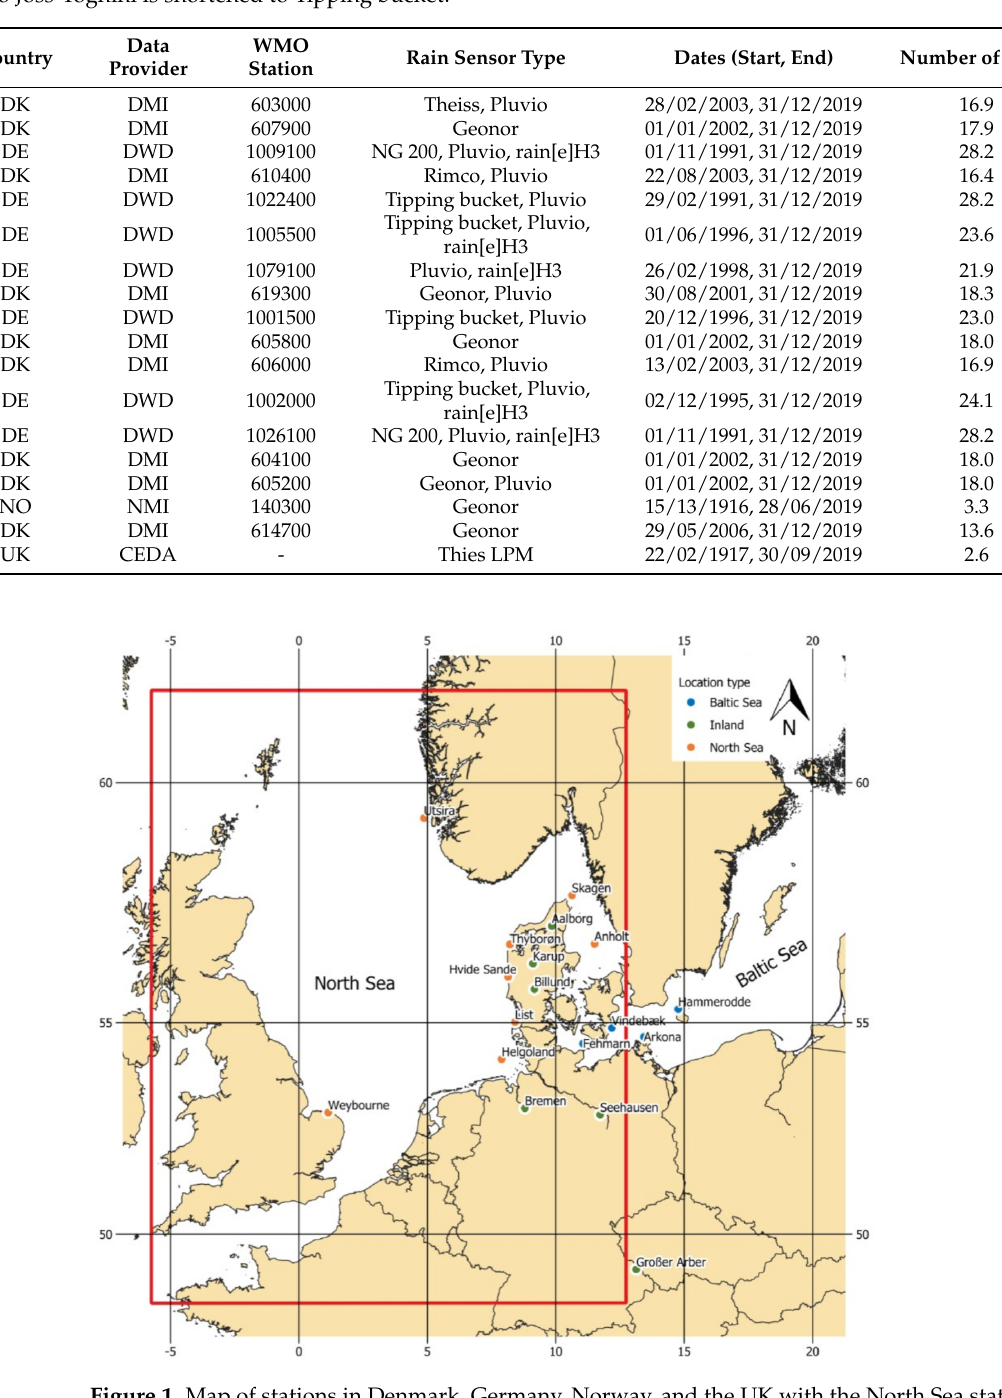
Figure 1. Map of stations in Denmark, Germany, Norway, and the UK with the North Sea stations in green, Baltic Sea stations in blue, and inland stations in green. The red rectangle indicates the area covered in Figure